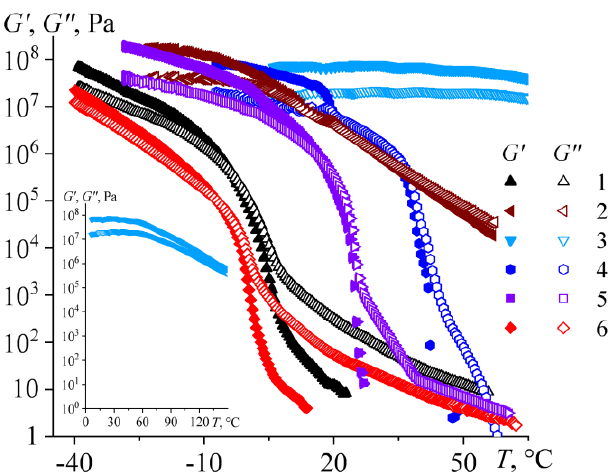
Figure 11. Typical temperature dependences of storage and loss moduli for different types of bitumens, whose numbers are presented in the legend. The inset shows the dependence for bitumen 3 in a broader temperature range.